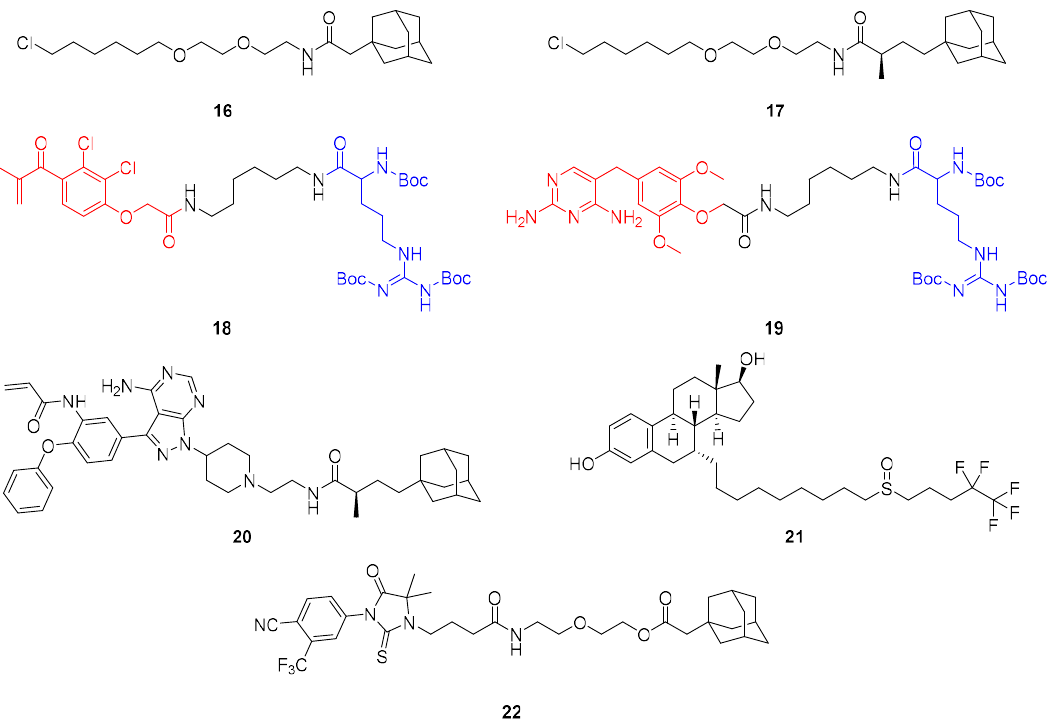
Figure 13. Hydrophobic tag (HyT)-containing bifunctional molecules that enable POI degradation via the proteasome. The HyTs in 16 and 17 are linked to hexyl chloride and bind HaloTag fusion proteins irreversibly. The Boc 3 Arg group (blue) can mediate POI degradation when bound to ligands (red) such as ethacrynic acid ( 18 ) or trimethoprim ( 19 ). Further examples of HyT-containing degraders are TX2-121-1 ( 20 ), the selective estrogen receptor downregulator (SERD) fulvestrant ( 21 ) and the selective androgen receptor degrader (SARD) SARD279 ( 22 ).